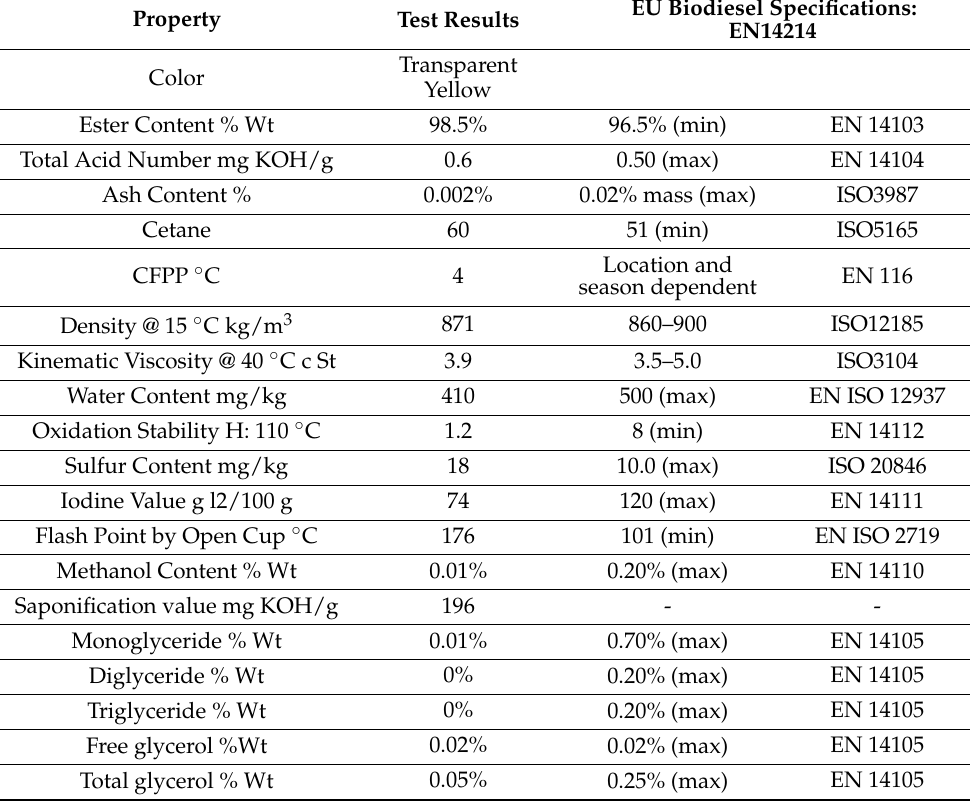
Table 2. Physical and chemical properties of distilled WCO biodiesel.